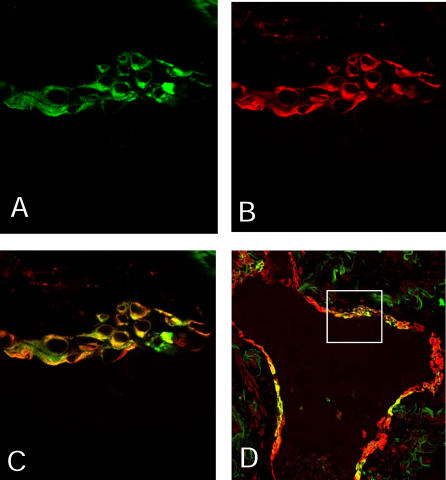
Osteopontin and MMP-7 Colocalization in IPF Lungs(A−C) MMP-7 staining is shown in green (A), osteopontin is shown as red staining (B), and overlap of staining is shown in yellow (C), suggest colocalization of MMP-7 and osteopontin in alveolar epithelial cells in IPF lungs (60×).(D) A lower-magnification image (20×) of the same region (A–C) with the same color coding. The white rectangle depicts area shown in (A−C).